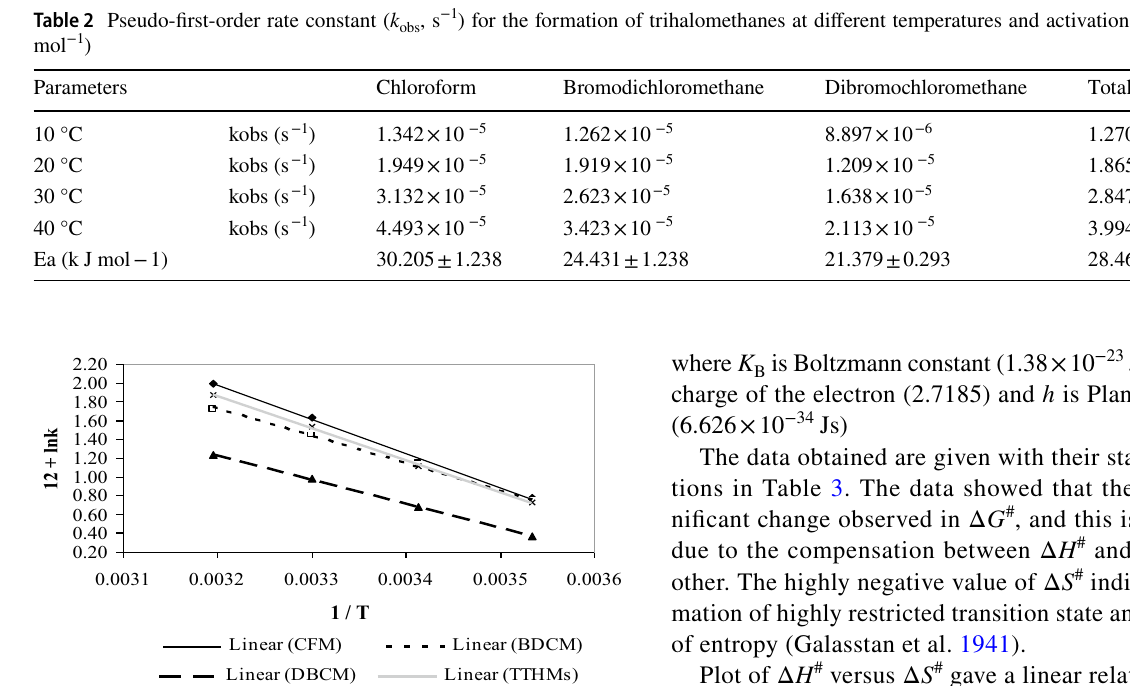
Fig. 2 Plot of ln k obs versus the reciprocal of the absolute temperature for the formation of trihalomethanes